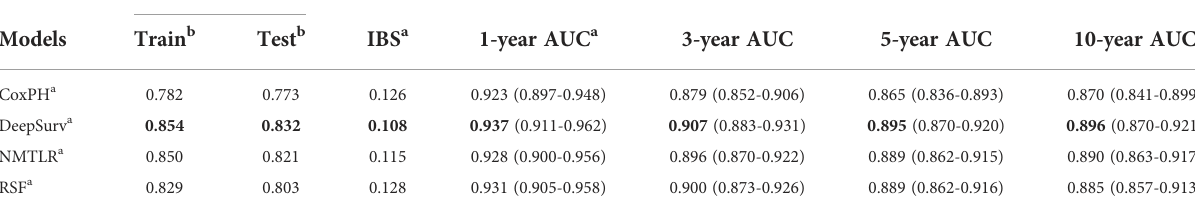
TABLE 3 Performance of four survival